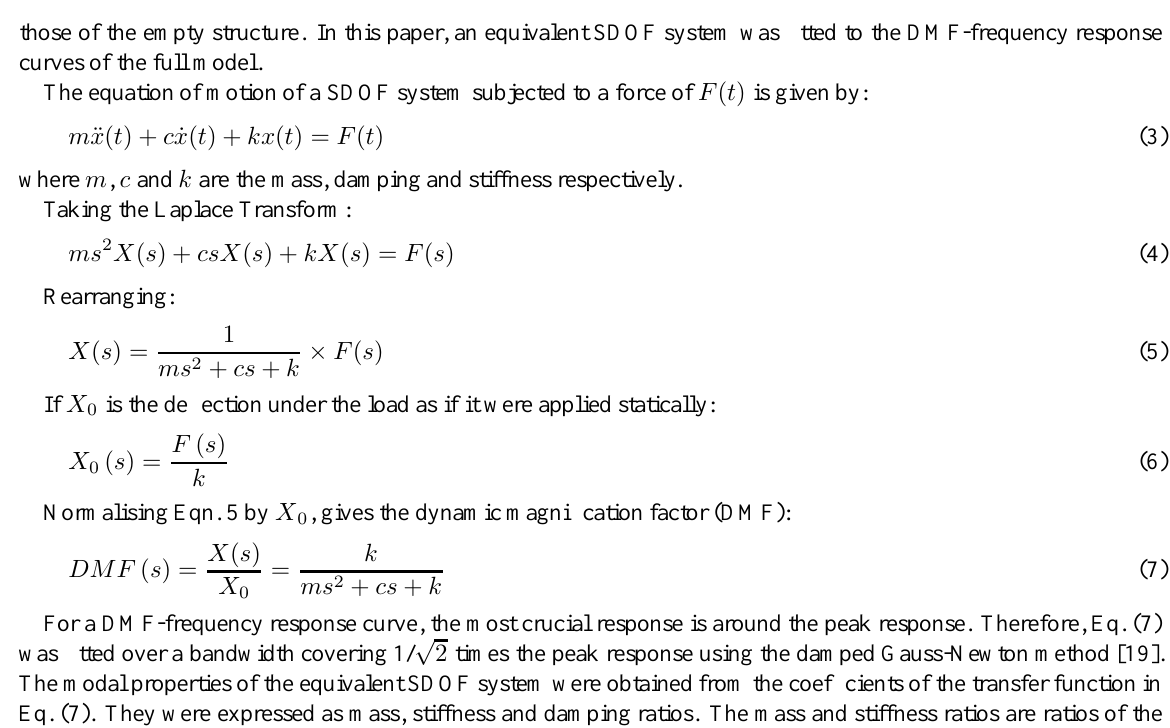
Fig. 4. DMF-frequency response curves for a 6 Hz structure with 50:50 seated/standing